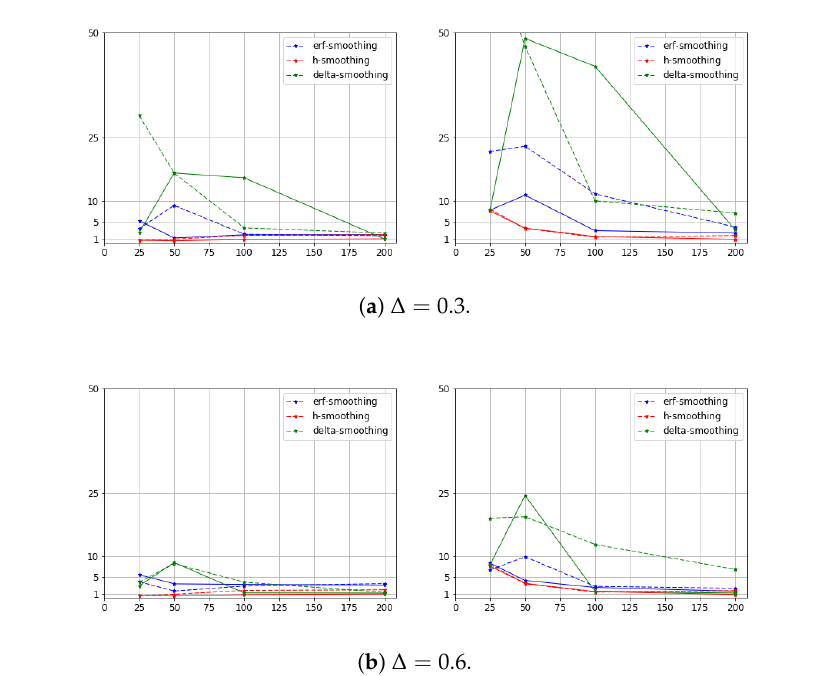
Figure 4. One-dimensional problem. Boundary conditions g = − 15. Numerical solutions using error function smoothing (blue color), smoothing in one spatial interval (red color), and linear smoothing using the ∆ interval (green color). Solid line for m = 200 and dashed line for m = 100. Left: relative L 2 errors for the solution at the final time. Right: relative L 2 errors for the phase change interface